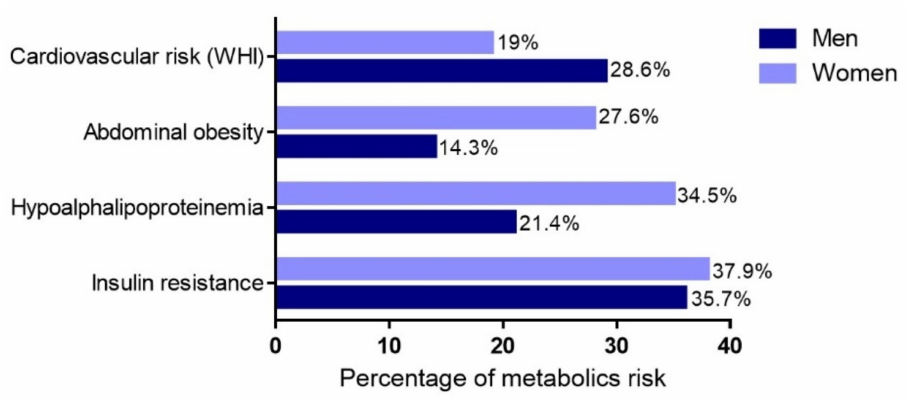
Figure 1. Metabolic risks by